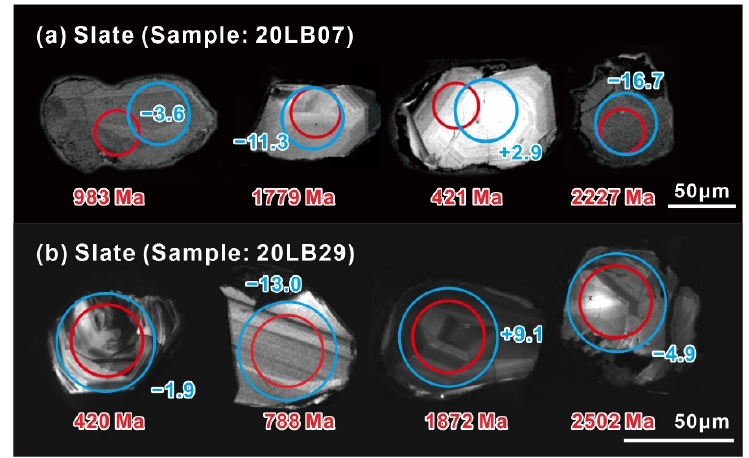
Figure 5. Representative cathodoluminescence (CL) images showing the morphologies and internal textures of zircon grains from the Middle Devonian Liba Group. ( a ) Sample 20LB07; ( b ) Sample 20LB29.